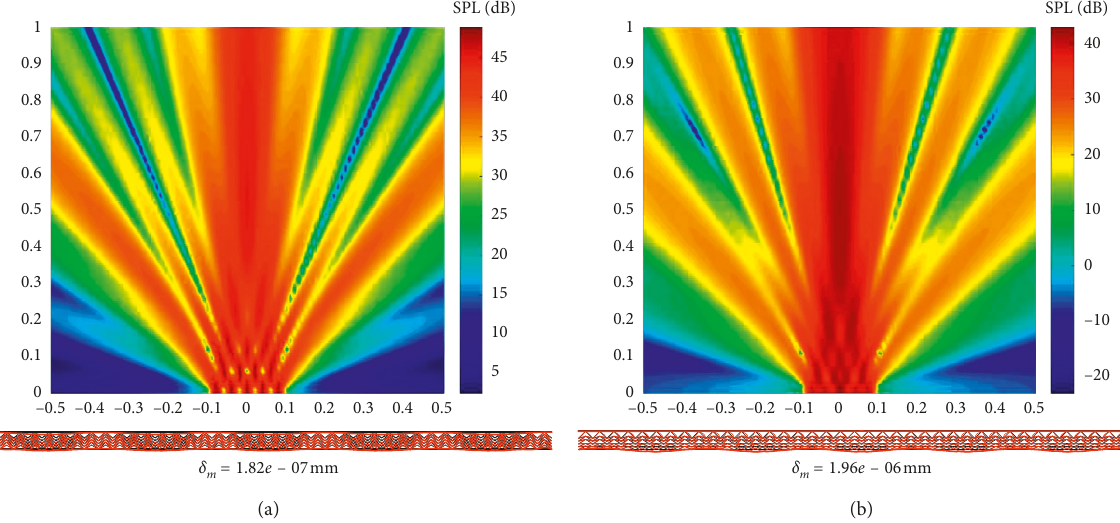
Figure 15: SPL distributions and dynamic deformations of the optimized models at 1400Hz: (a) the optimized gradient DNPR model and (b) the optimized gradient INPR